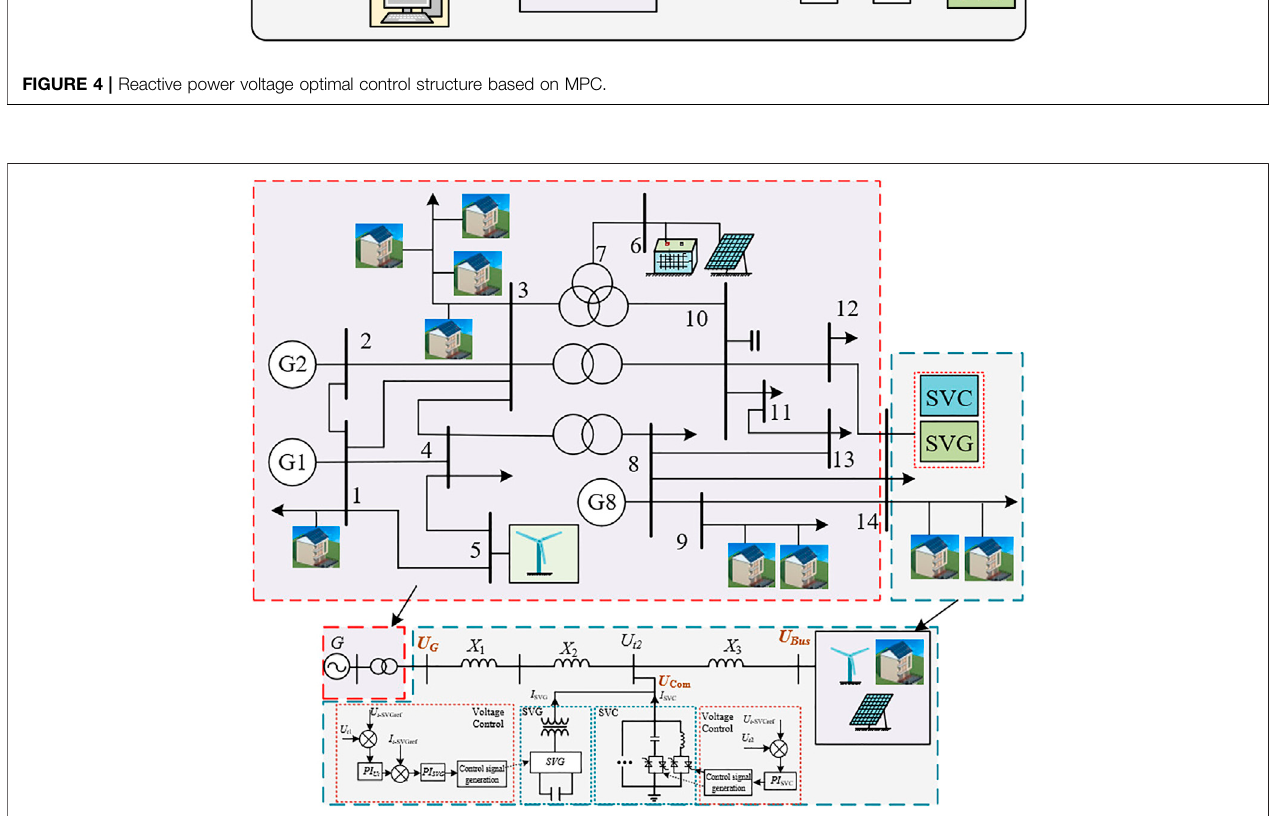
FIGURE 5 | Schematic diagram of simulation system.